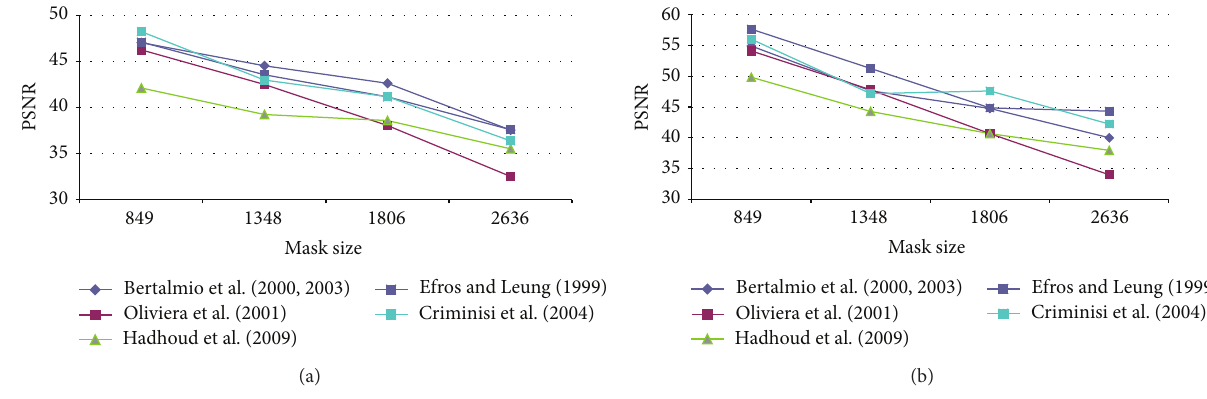
Figure 4: PSNR results for (a) Lena and (b) Peepers test image.